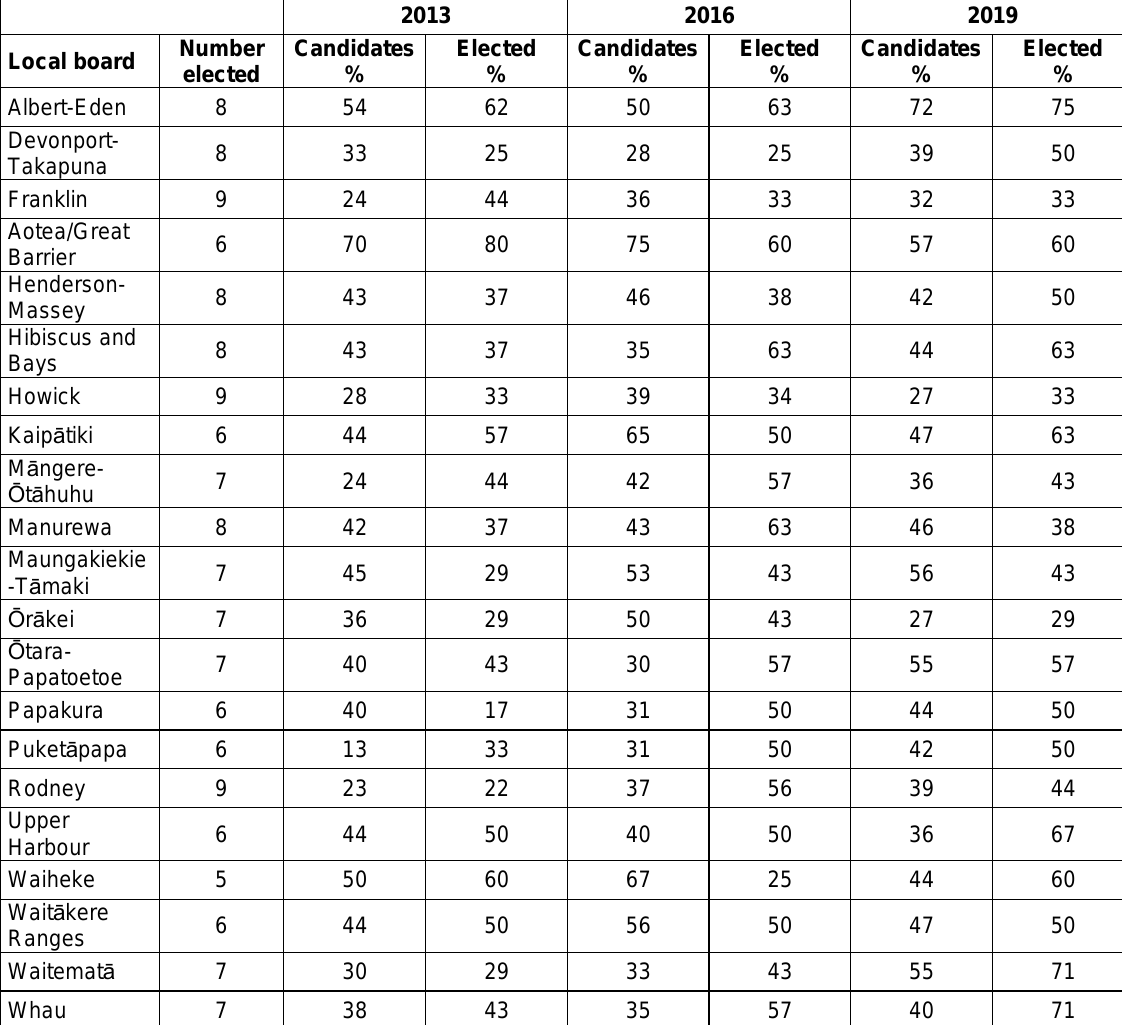
Table 4: Percentage of women candidates and women elected by individual local